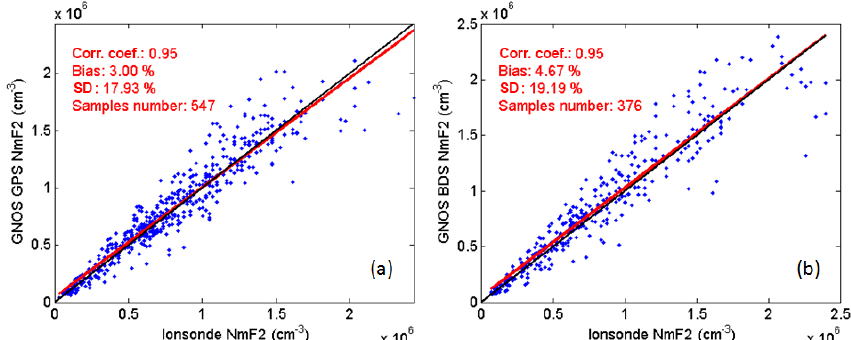
Figure 8. Comparison of NmF2 measurements from GNOS GPS (a) and BDS (b) occultation and ionosonde data. The linear regression of the absolute NmF2 values was computed using a standard difference technique, in which the black line is y = x , the red line is the fitted regression, corr. coef. is the correlation coefficient, bias is the statistical bias, and SD is the standard deviation (source: Bai et al., 2018).